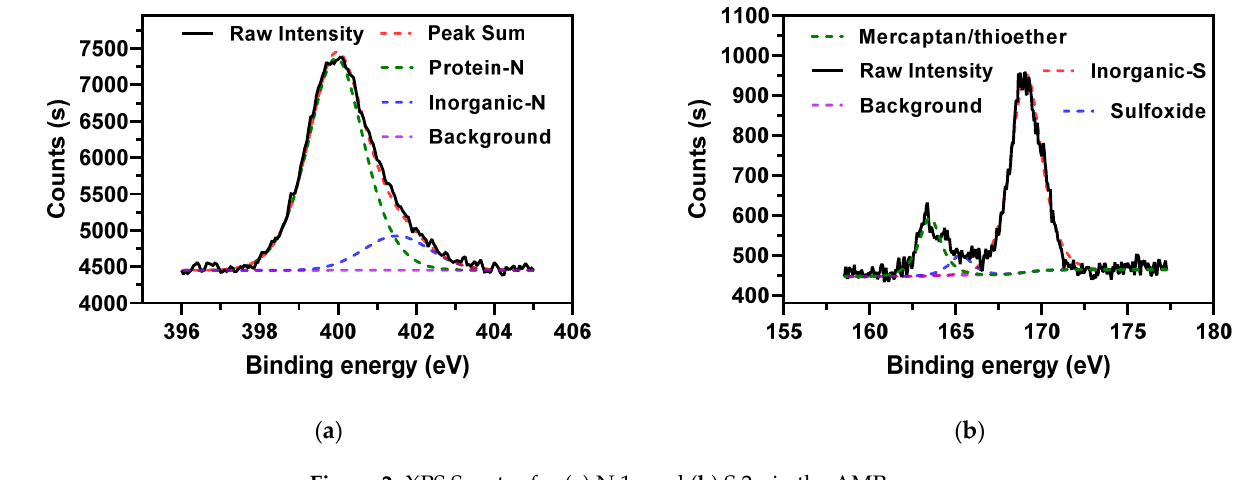
Figure 2. XPS Spectra for ( a ) N 1s and ( b ) S 2p in the